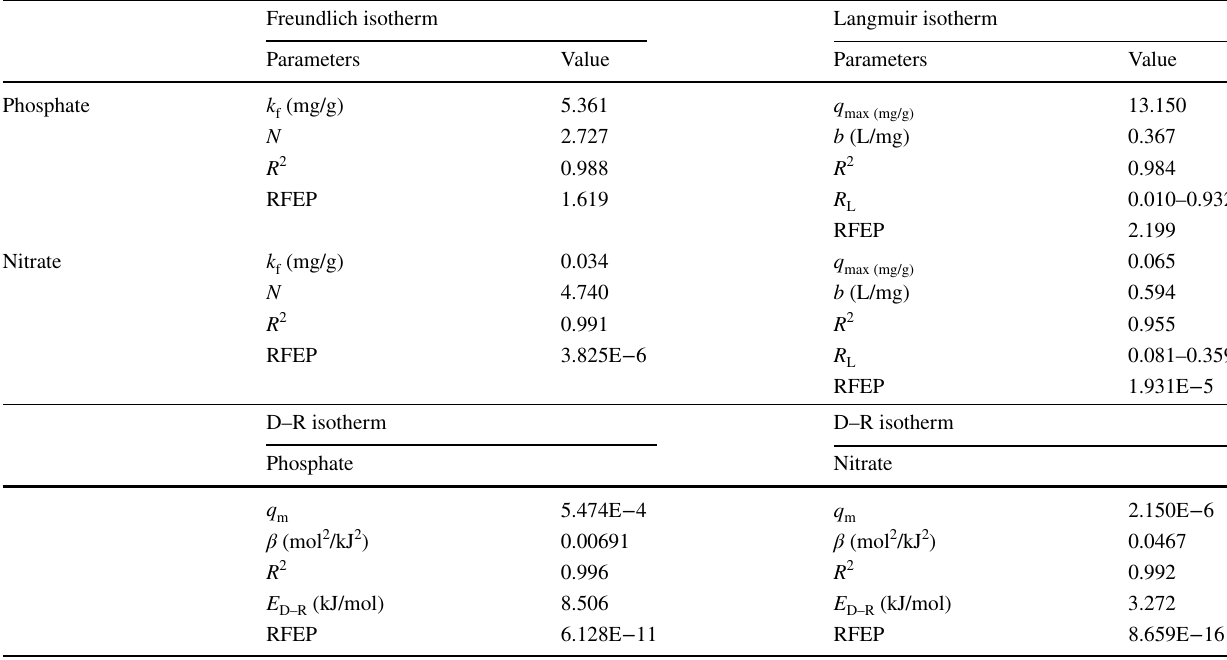
Table 2 Isotherm parameters for the removal of nitrate ions by untreated SWR Freundlich isotherm Langmuir isotherm Parameters